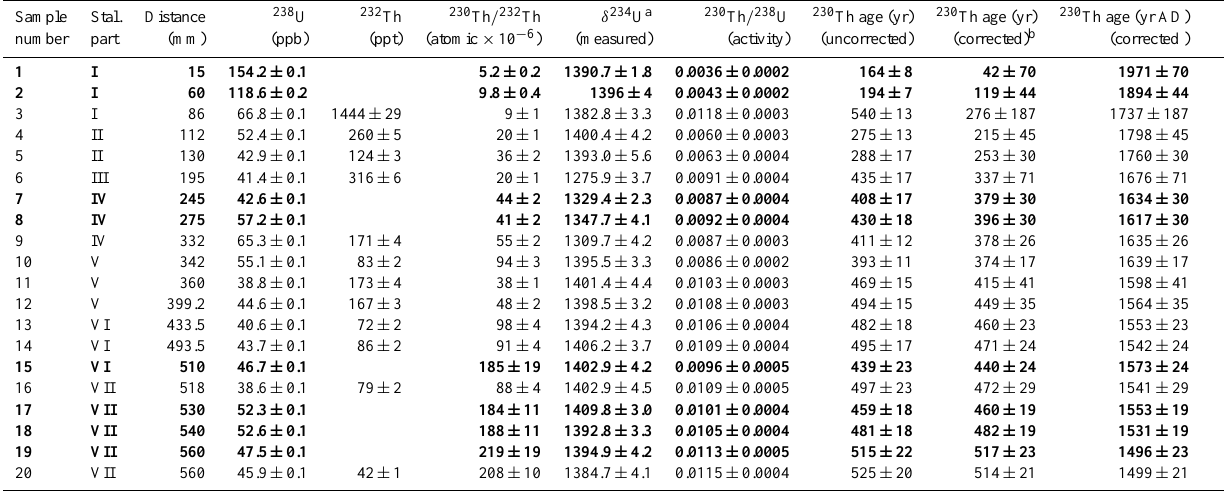
Table 1. U / Th measurements (University of Minnesota) of the Proserpine stalagmite. All ages are converted to before 2013. Ages number 1, 2, 7, 8, 15, 17, 18 and 19, marked in bold, are the U / Th ages from Verheyden et al. (2006). The error is 2 σ error. Sample Stal.